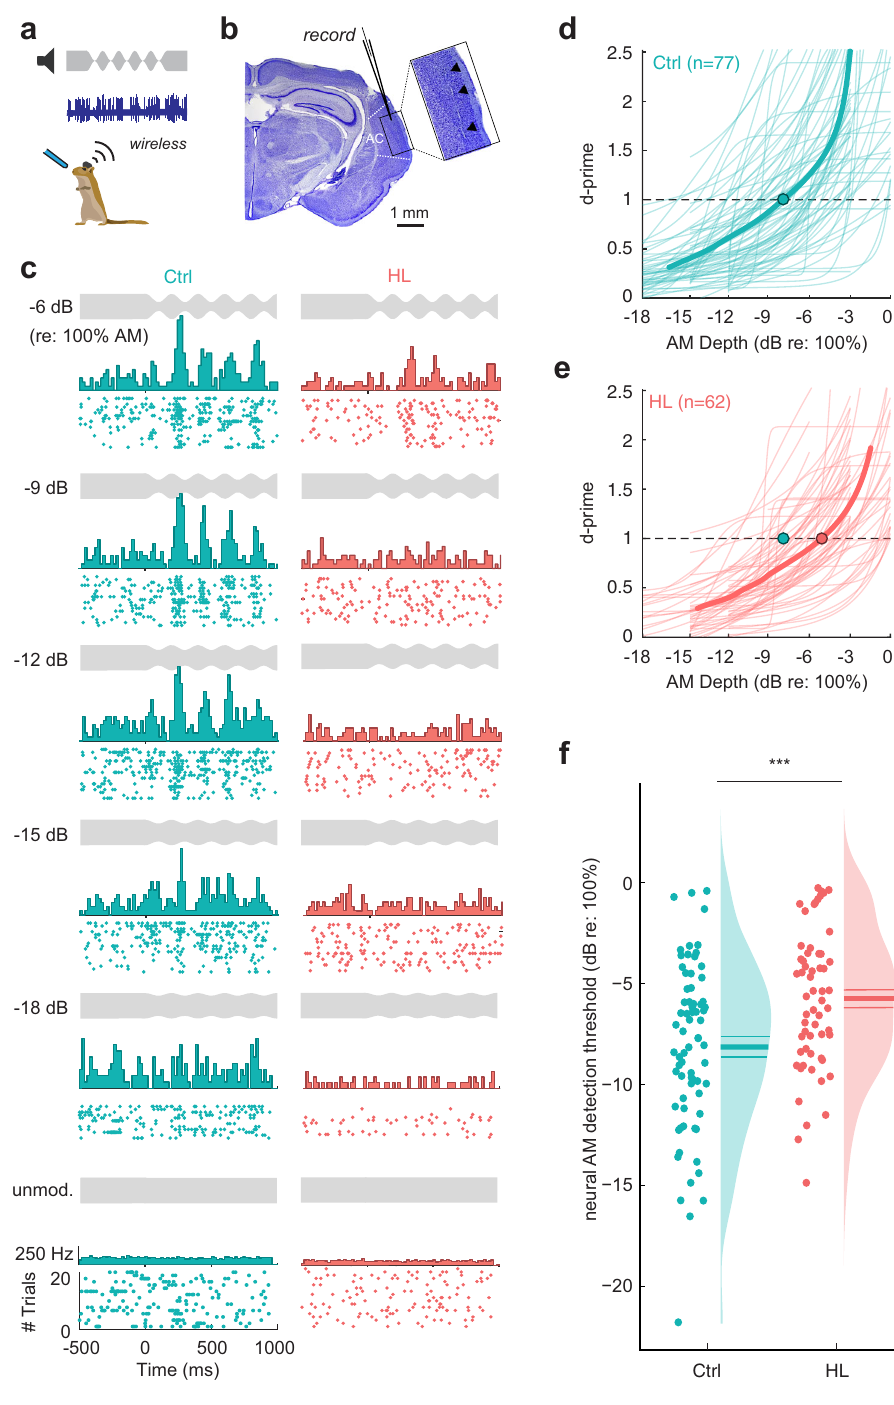
Fig. 5 Single-unit analysis reveals poorer neural detection thresholds in the auditory cortex. a Chronic 64 channel electrode arrays were implanted into the auditory cortex (AC) of a subset of control ( n = 7) and HL ( n = 9) animals, and wireless neural recordings were collected as they performed the AM depth detection task. b Representative Nissl-stained coronal section from one implanted animal. Inset shows electrode track through primary AC (see arrows). c Raster plots with poststimulus time histograms are shown for two example single units from a control (left panel; Subject ID F276484) and HL (right panel; Subject ID M277481) animal. Plots are arranged in order from larger AM depths (top) to smaller depths (towards bottom; see depth stimulus in gray for reference). d , e The fi ring rate of single units that met the criteria for AM sensitivity were transformed into d ′ values (see Methods section). Neural d ′ values were fi t with a logistic function and plotted as a function of AM depth for a population of control ( n = 77) and HL ( n = 62) single units. Thin lines indicate individual fi ts, and the thick line indicates the population mean of the fi ts. Neural thresholds were de fi ned as the AM depth at which the fi t crossed d ′ = 1. Circle indicates the mean neural depth threshold for each population. f Neural thresholds are plotted for control and HL animals. Individual thresholds are shown (circles), along with a half-violin plot indicating the probability density function. Horizontal lines indicate the mean ± SEM. Single units from HL animals exhibit poorer neural depth thresholds than control single units ( p = 0.0007, one-way